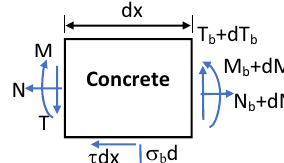
Figure 3: Stress distribution in the concrete.